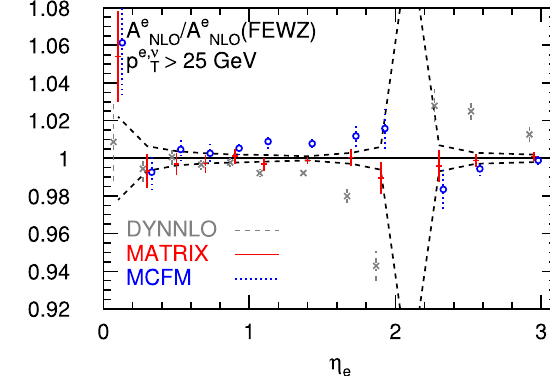
Fig. 4 The ratio of the NLO QCD corrections to the electron charge asymmetry distribution A e in W ± -boson production at computed with DYNNLO , MATRIX and MCFM to ones by FEWZ . Cuts